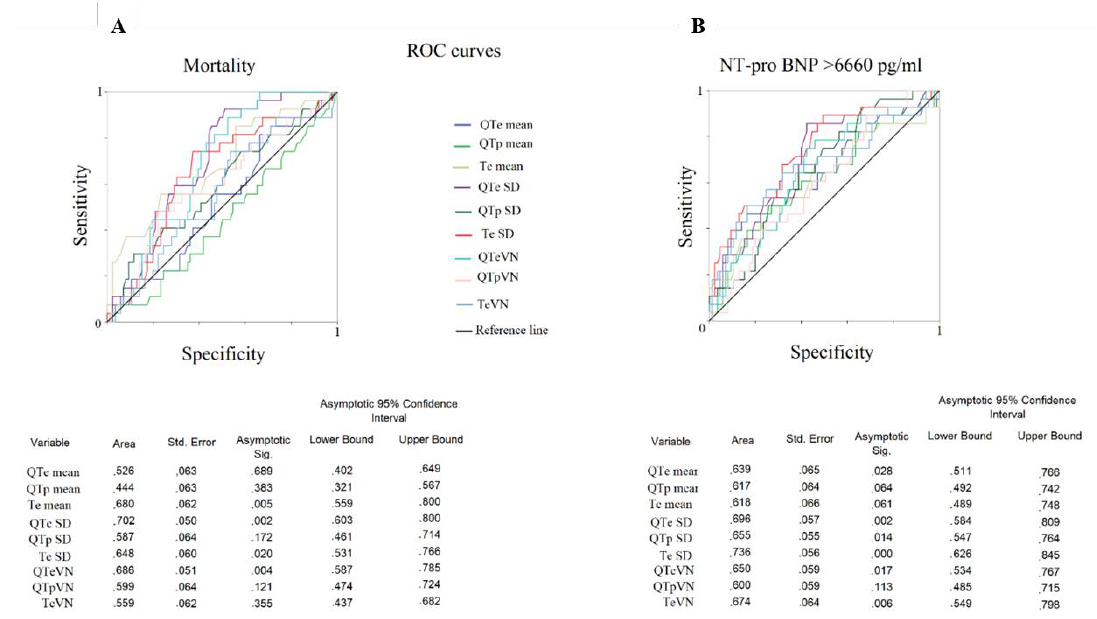
Figure 3. ( A , B ) ROC curve of statistically significant examined variables. Sensitivity–specificity of different variables for mortality ( A ) and higher NT-proBNP levels (≥75th percentile) ( B ). Univariable Cox regression analysis reported a significant relationship between 30-day mortality and QTe SD (hazard ratio: 1.10, 95% confidence limit: 1.03–1.18, p < 0.05), mean Te (hazard ratio 1.02, 95% confidence limit: 1.01–1.04, p < 0.001) and Te SD (hazard ratio 1.12, 95% confidence limit: 1.01–1.23, p < 0.001) (Table 3). All number value in the table of the figure should be intended as follow: .526 means 0.526.